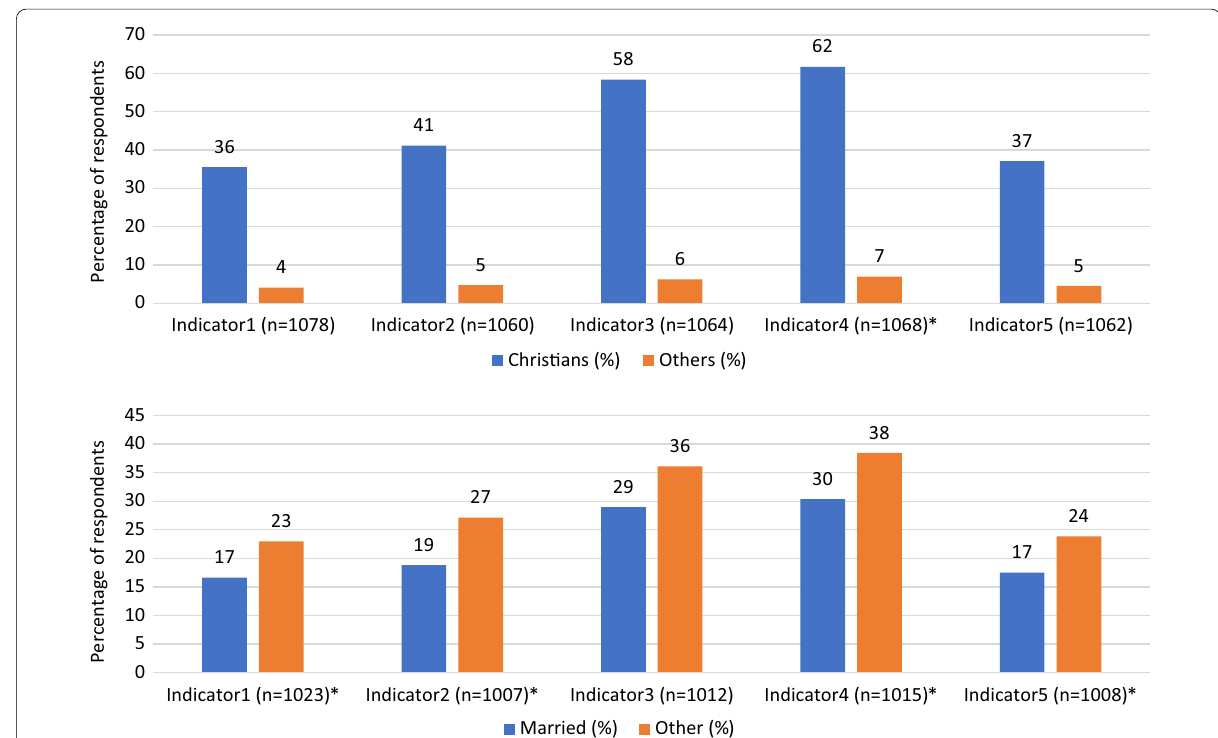
Fig. 2 Perceptions on COVID‑19 vaccination: disaggregated by religion and marital status. Source: Field Data (2020); Legend: Indicator1 (Participate in COVID‑19 vaccine trial); Indicator2 (Advise someone to participate in COVID‑19 vaccine trial); Indicator3 (Accept/take vaccination for COVID‑19); Indicator4 (Advise someone to accept/take COVID‑19 vaccination); Indicator5 (Willingness to pay for COVID‑19 vaccination); *Chi‑square test statistically significant at 95% confidence